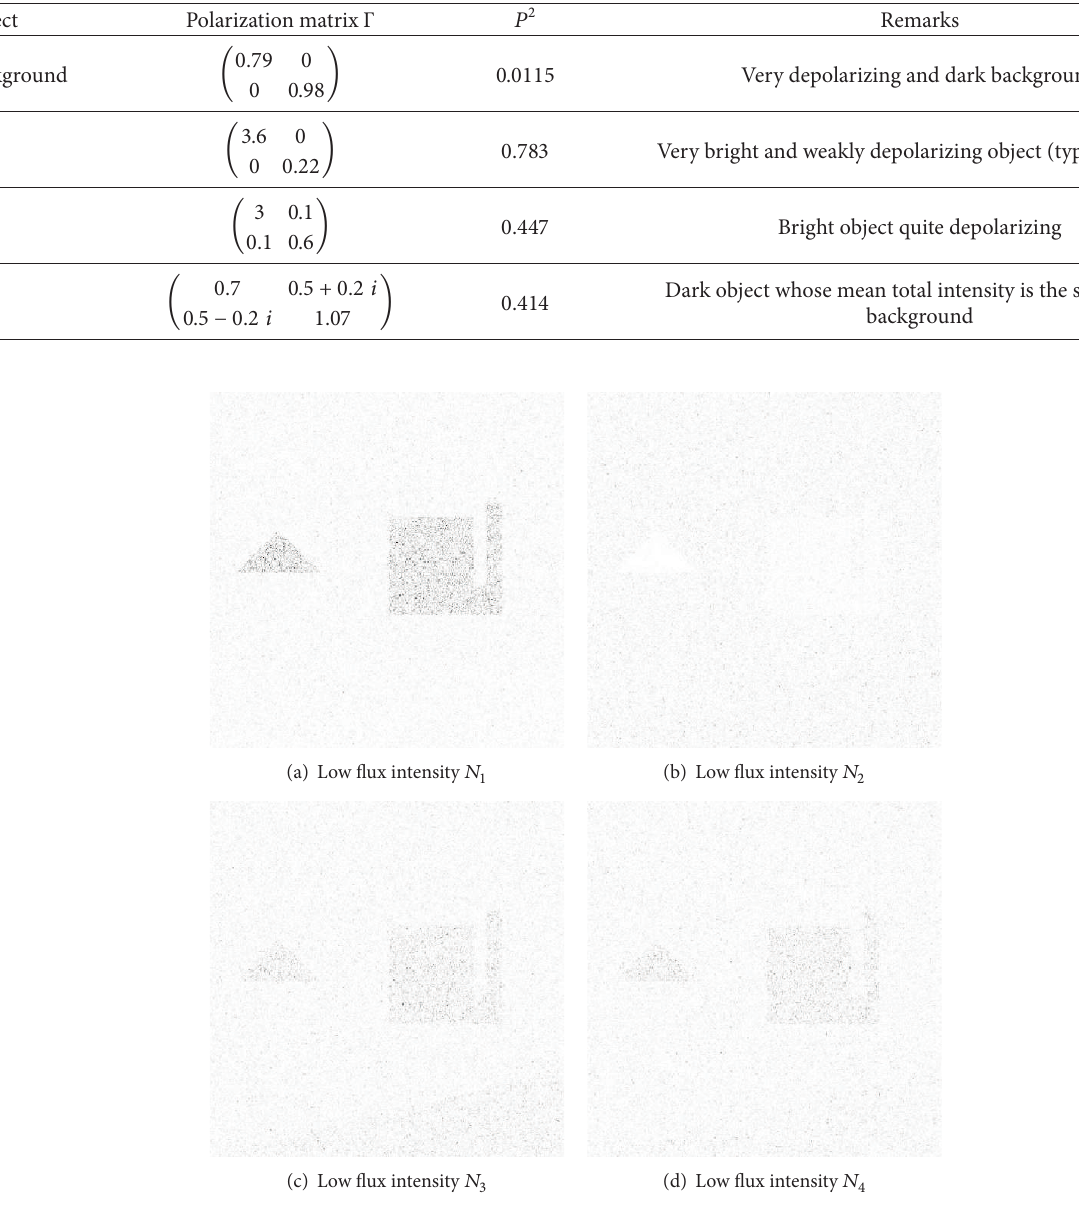
Table 5: Polarimetric properties of elements that compose the scene displayed in Figure 4.